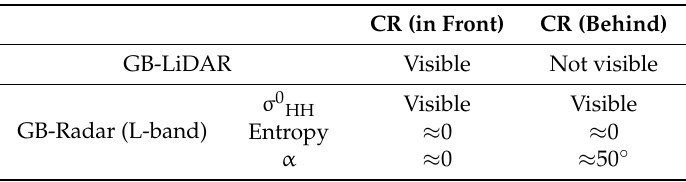
Figure 6. Range profiles of α and entropy obtained using GB-radar. Table 5. Characteristics of signals from CRs.